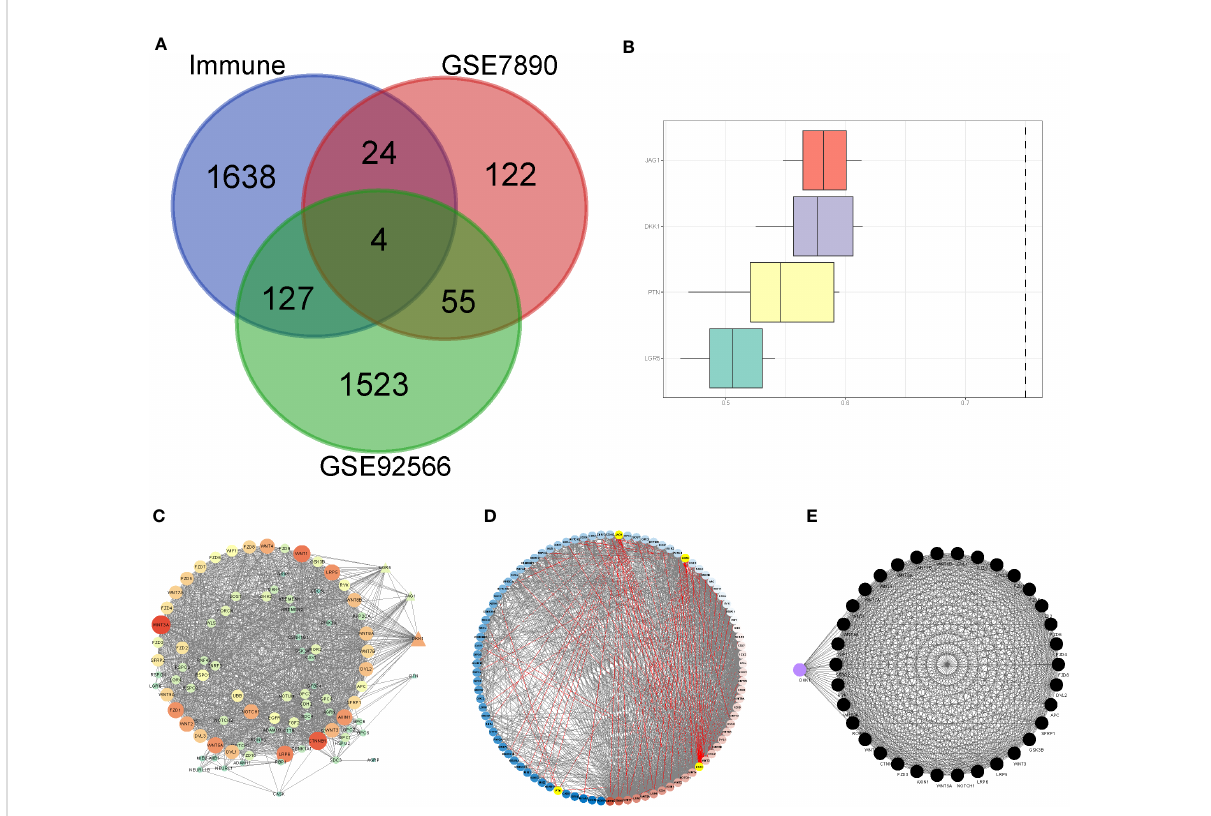
FIGURE 3 Principal component analysis and identi fi cation of differentially expressed immune-related gene (DEIGs). (A) Intersection of differentially expressed genes and immune-related genes. (B) Summary of the functional similarities of four DEIGs. (C) protein – protein interaction (PPI) network sized by degree. (D) PPI network colored by degree. (E) MCODE.